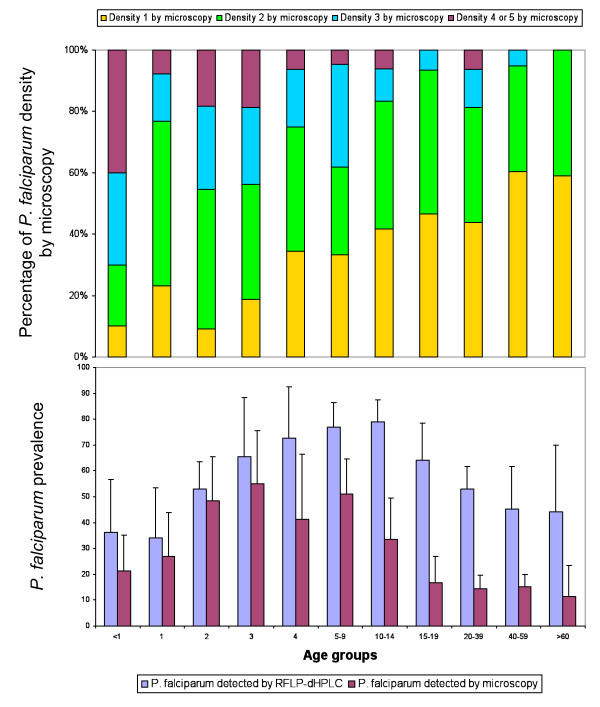
Prevalence of P. falciparum by age diagnosed by microscopy and RFLP-dHPLC. Density class 1 for 1--10 parasites per 100 thick film fields; Density class 2 for 11--100 parasites per 100 fields; Density class 3 for 1--10 parasites per single field; Density class 4 for 11--100 parasites per single field; Density class 5 for > 100 parasites per single field (WHO, Basic Malaria Microscopy, Geneva, Switzerland)